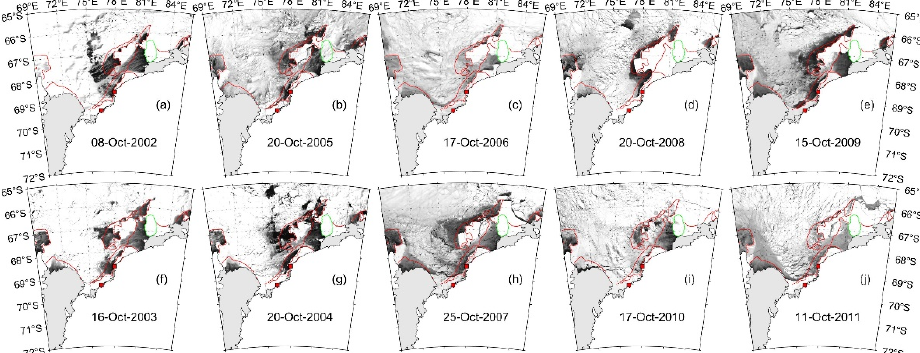
Figure 10. Shapes of the two types of fast ice in the FLBP in different years from MODIS visible images. The shape of type A fast ice is shown in the images in the first row ( a – e ), and the shape of type B fast ice is shown in the images in the second row ( f – j ). The POF = 24% of the years from 2002 to 2011 is shown by the red lines, and the outline of Iceberg D15 is denoted by the green lines. The southern boundary of the fast ice in the FLBP never exceeded 67.5°S in the nor- mal years during the study period. Although a few small grounded icebergs were present between 67.5–68°S, i.e., next to the eastern boundary of the FLBP (Figure 7c), their sporadic positions and small quantity did not allow for the formation of fast ice. The region be- tween the area south of 68°S and the fast ice in the DaP is the Dubinin Trough (Figure 1), where is too deep for icebergs to ground. The channel for transferring new ice formed in the BaP remained open because of the lack of fast ice between 67.5°S and the fast ice in the DaP.